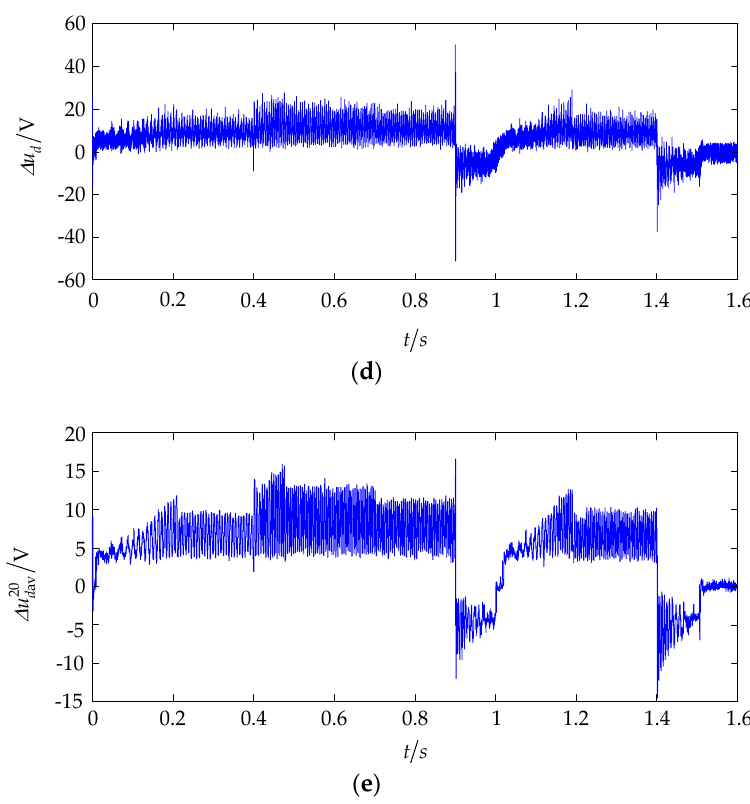
Figure 11. The simulation results with a coil ISCF under various operation conditions: ( a ) The reference speed and the actual speed; ( b ) The reference load torque and the electromagnetic torque; ( c ) The d -axis voltages of two sets of windings; ( d ) ∆ u d ; ( e ) ∆ u 20 av d